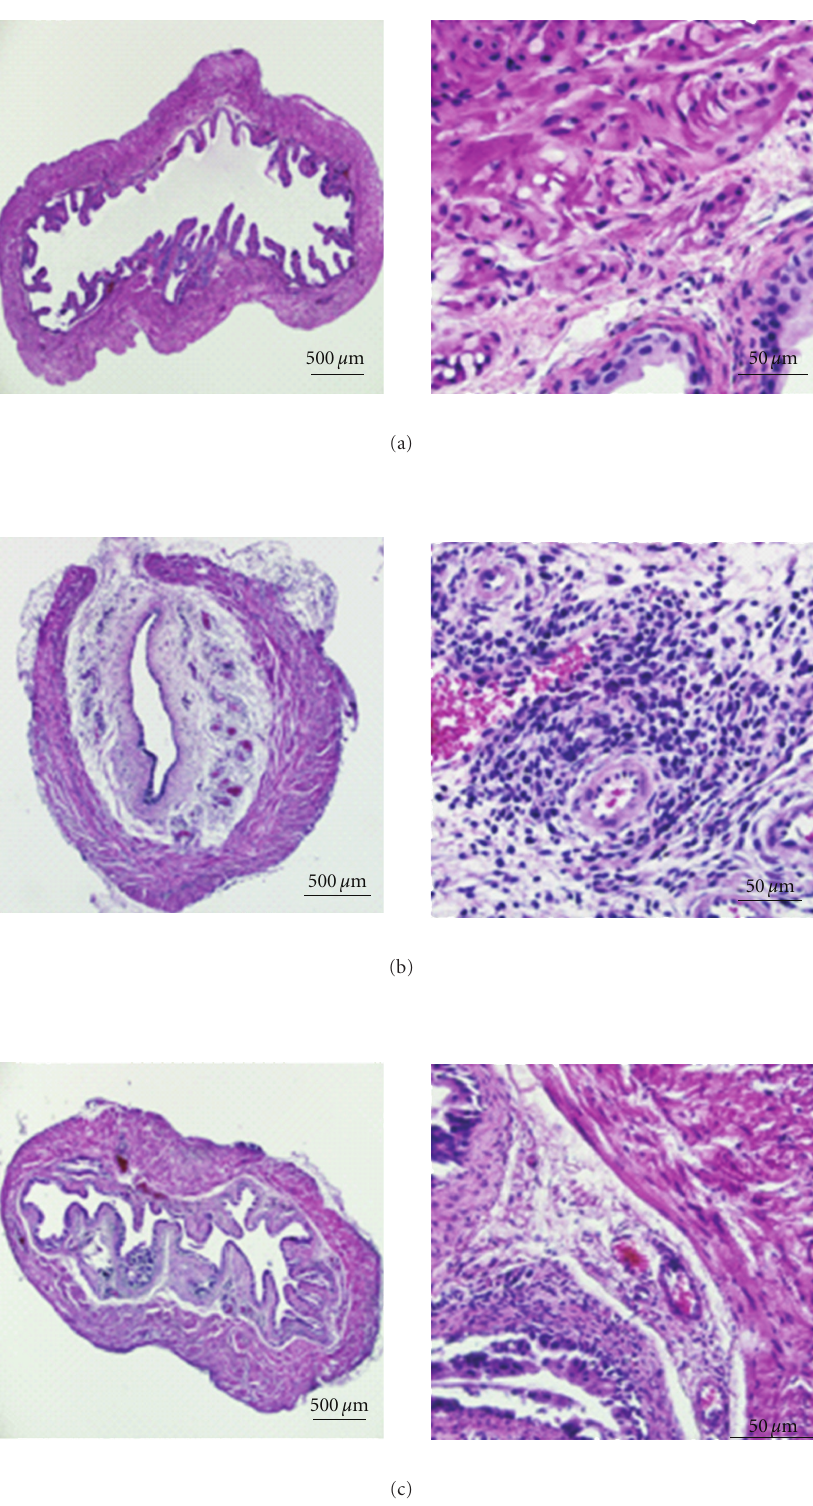
Figure 2: Intravesical DMSO treatment reduces bladder histopathology in acute autoimmune cystitis. Acute cystitis was induced and treated in URO-OVA mice as shown in Figure 1. At day 10, the bladders were collected, prepared for histological cross-sections, and stained with H&E solution. (a) The normal bladder showing unremarkable mucosa and muscularis. (b) The PBS-treated bladder showing remarkable cellular infiltration, interstitial edema, and mucosal hyperemia in the lamina propria. (c) The DMSO-treated bladder showing scattered cellular infiltration and minimum edema and hyperemia. The slides are representative of 5 bladders in each group. Magnification: × 40 for the left pane and × 400 for the right